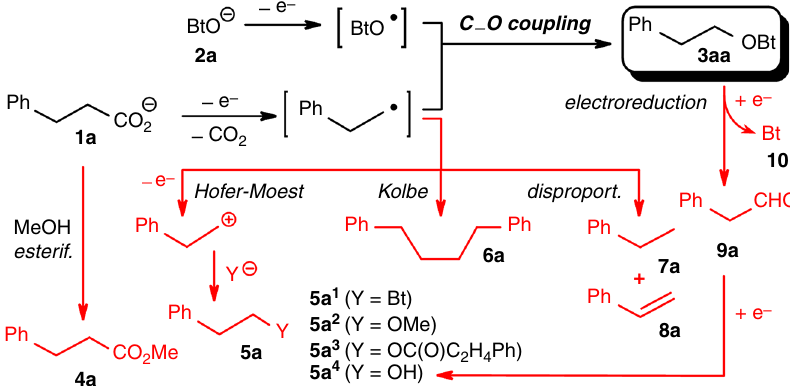
Fig. 2 Products derived from the electrolysis of 1a and 2a in MeOH. Red is used for undesired side-products obtained during